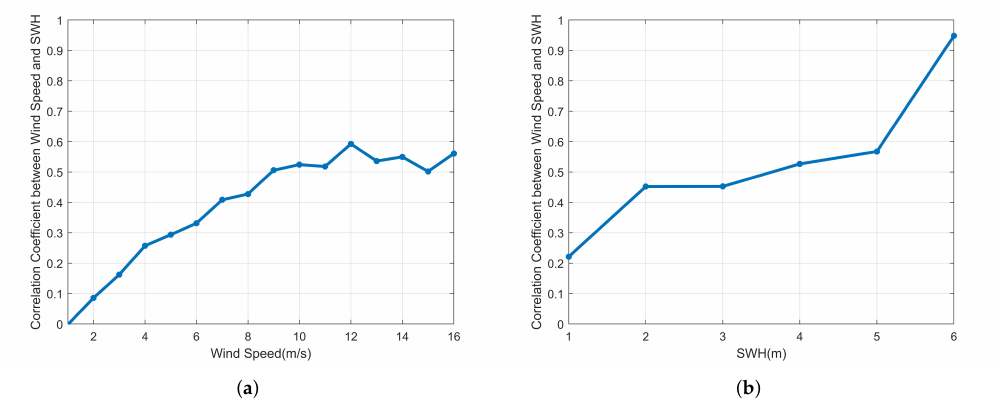
Figure 12. Spearman’s rank correlation coefficients between wind speed and SWH at 5° incidence angle. ( a ) at different wind speeds; ( b ) at different SWHs.